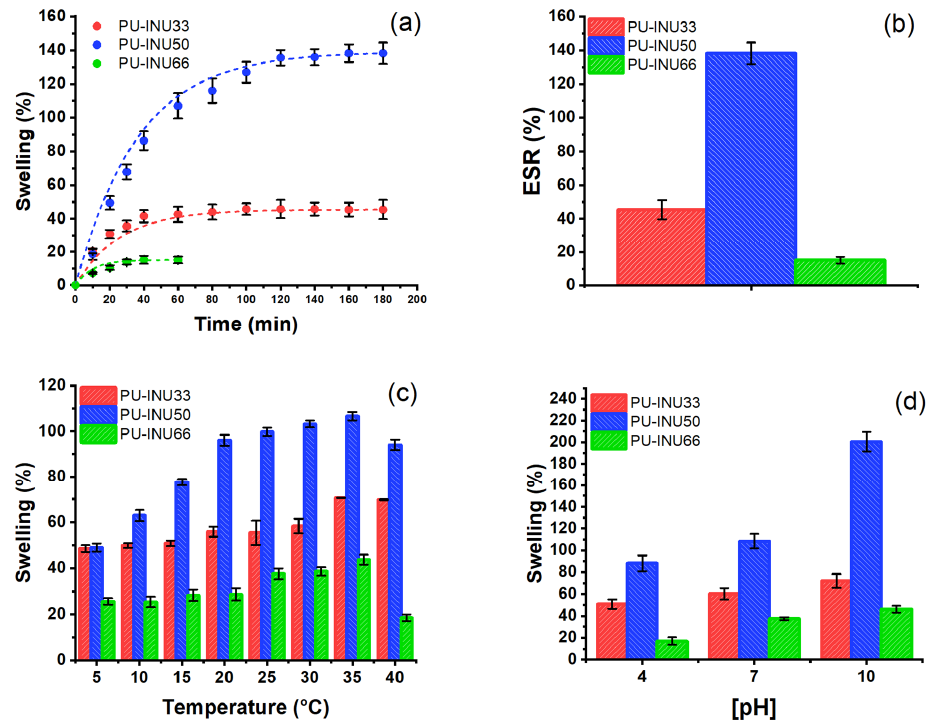
Figure 6. Swelling properties of the PU–INU’s: ( a ) swelling profile against time, ( b ) maximum swelling ratio against mol % of inulin per mol of polyol, ( c ) swelling ratio at different temperatures, and ( d ) swelling ratio at different pH.